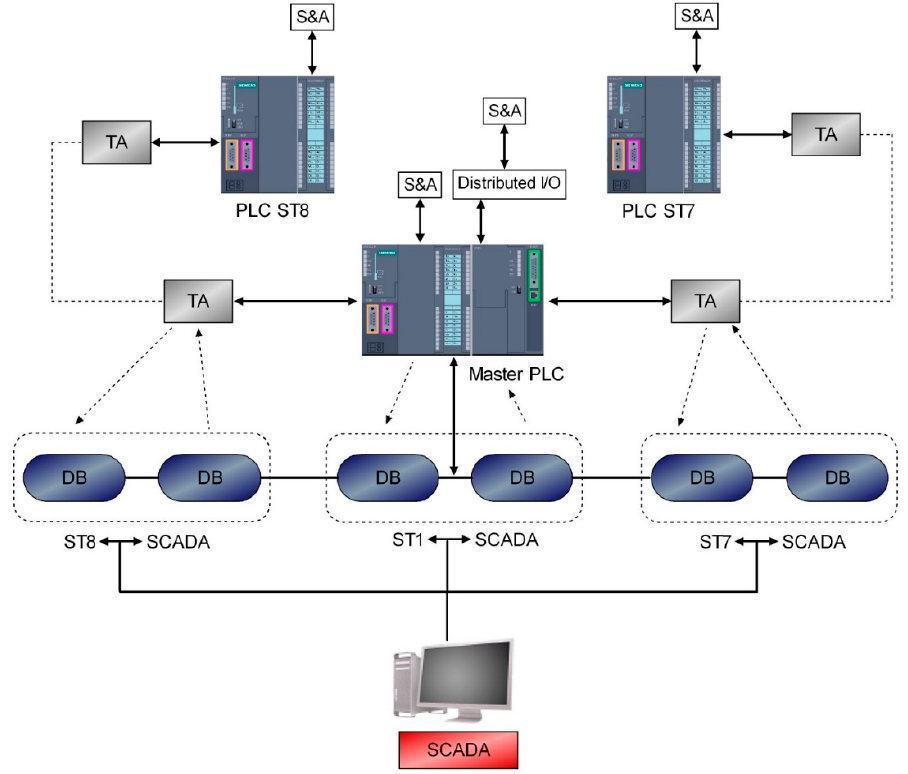
Figure 12. Connection scheme between signals of S&A and the SCADA system through DB blocks.